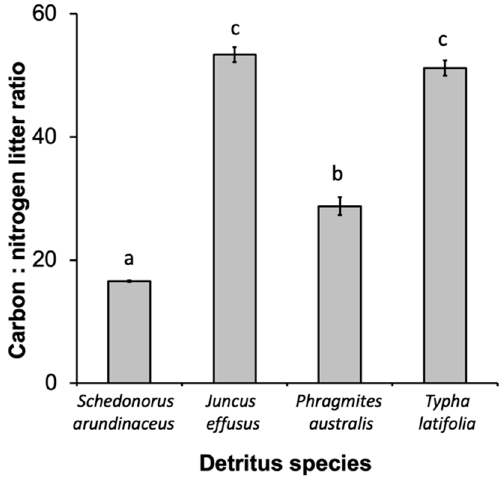
Figure 3. Carbon:nitrogen ratio for each detritus species. Different letters above bars denote statistically significant differences (experimentwise α = 0.05, sequential Bonferroni).